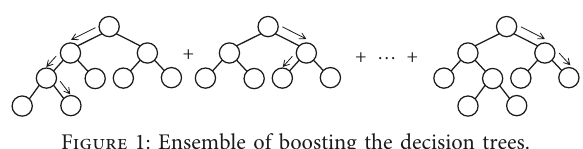
Figure 1: Ensemble of boosting the decision